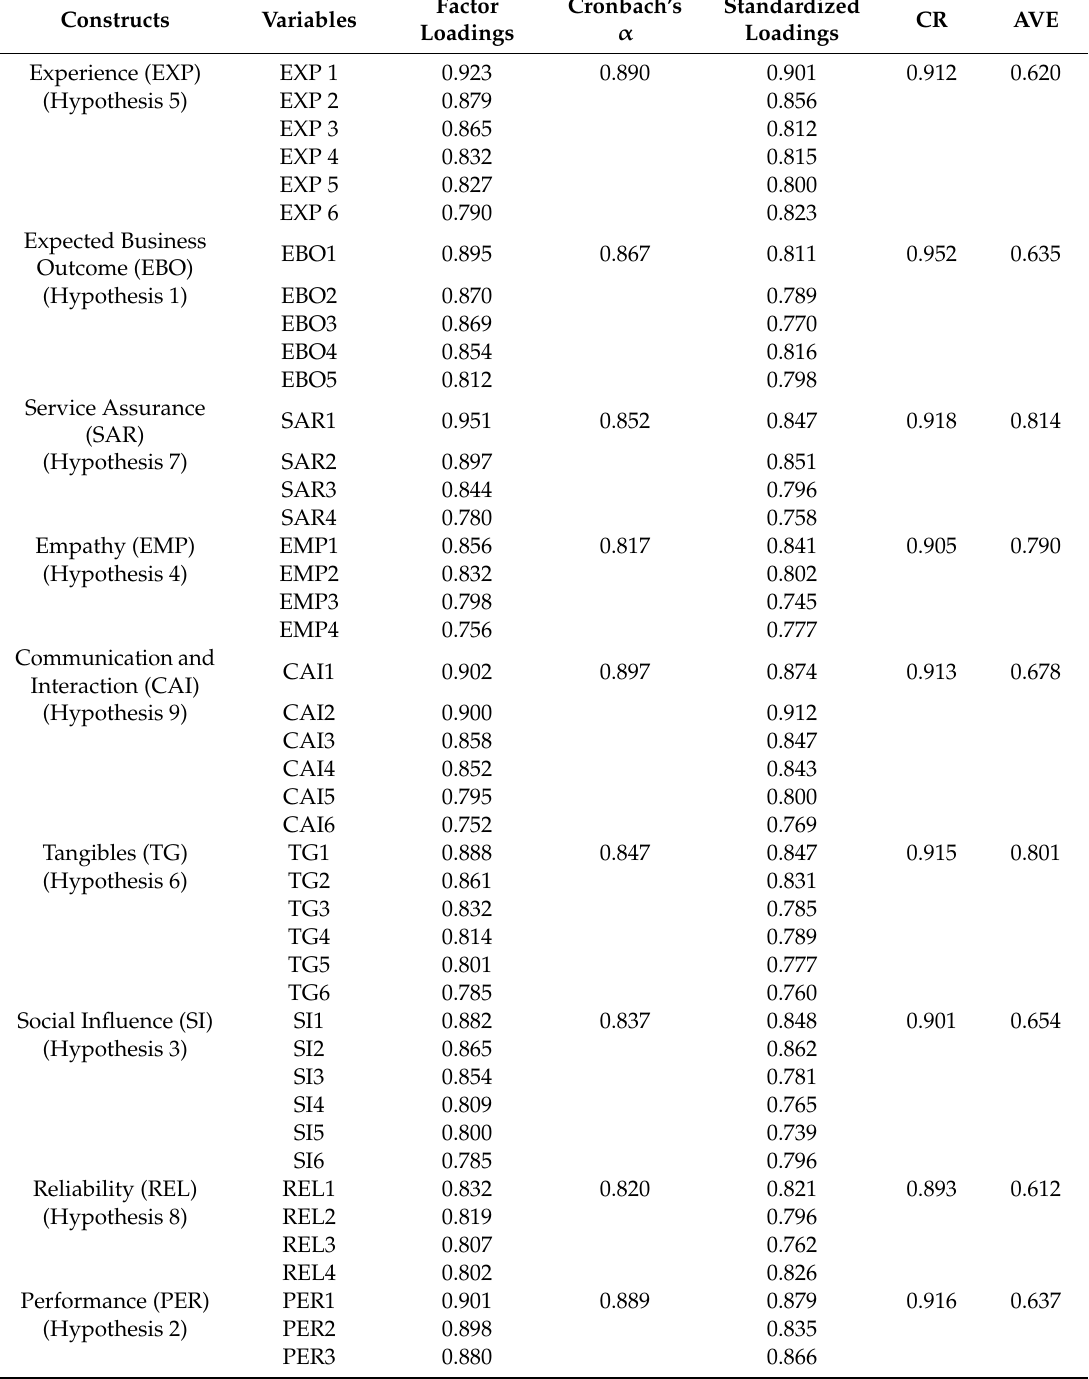
Table 2. Exploratory and confirmatory factor analysis